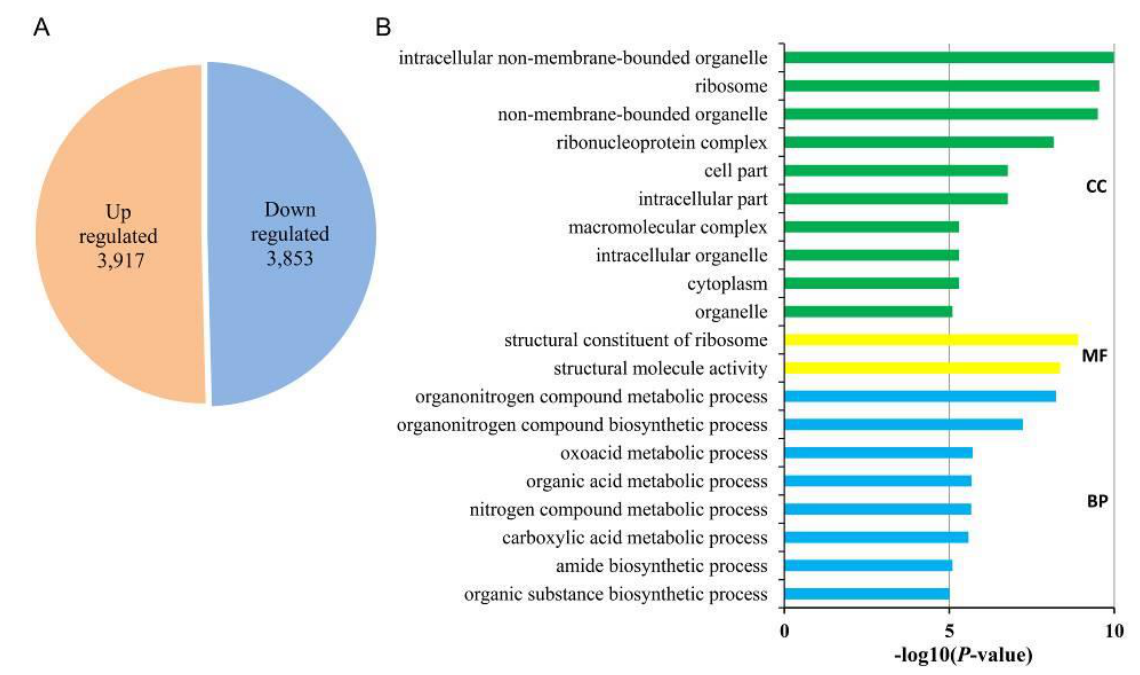
Figure 2. The differentially expressed genes (DEGs) in leaves of P . deltoides ‘Danhong’ and P. simonii ‘Tongliao1’. ( A ) Statistics of DEGs in leaves. ( B ) Enriched gene ontology (GO) terms of DEGs in leaves. BP: biological process, CC: cellular component, MF: molecular function.